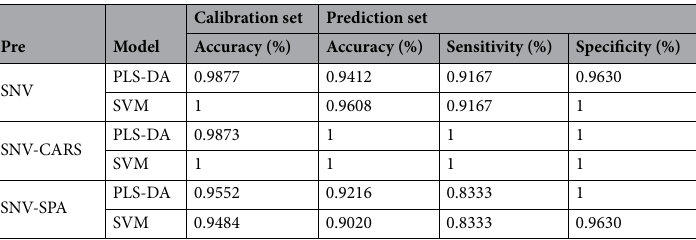
Table 3. Classification results of the PLS-DA and SVM models based on band screening under SNV preprocessing.